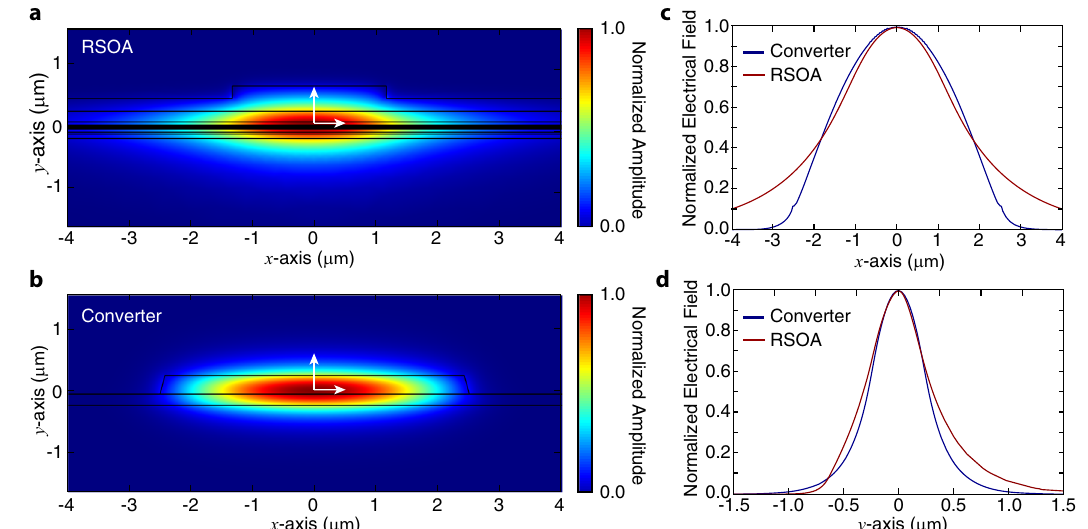
Fig.5|Designofthespot-sizeconverter.a , b Thesimulatednormalizedelectrical fi eldof themodepro fi lefromatypicalRSOAgainchip andthe designed converter respectively. c , d The normalized electrical fi eld of the simulated mode pro fi le